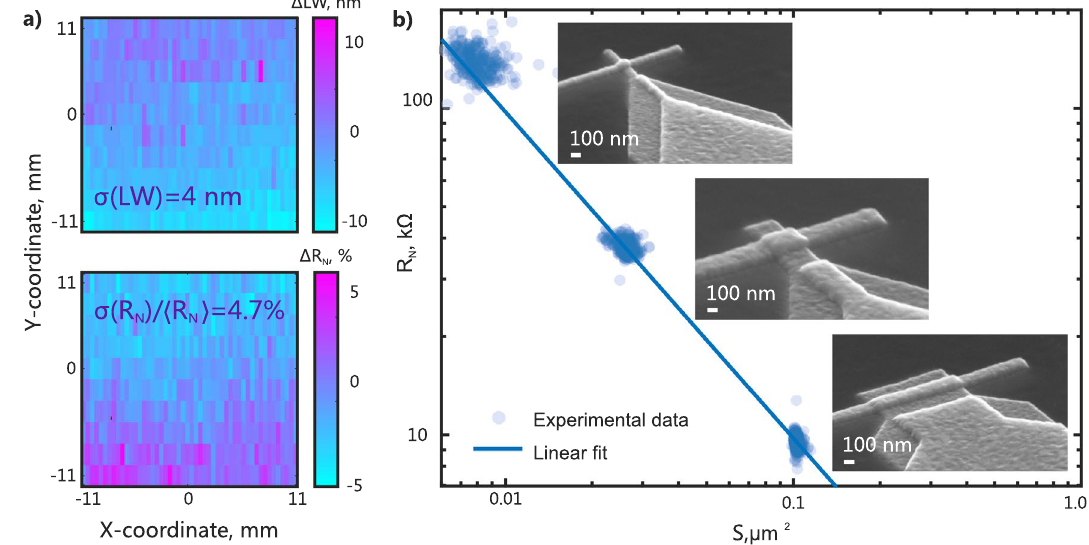
Figure 4. ( a ) Heat maps of measured top electrode LW and resistance RN for 150 × 170 nm 2 junctions. For both the LW map and the resistance map, there is a visible gradient stemming from evaporation source imperfection. ( b ) Measured resistance vs. measured junction area. Junctions were fabricated in three area groups: 0.008, 0.025 and 0.12 μm 2 . Solid line is a linear fit. SEM images of the junction in the corresponding junction area groups. SEM-images show fabricated Josephson junctions with corresponding 0.008, 0.025 and 0.12 μm 2